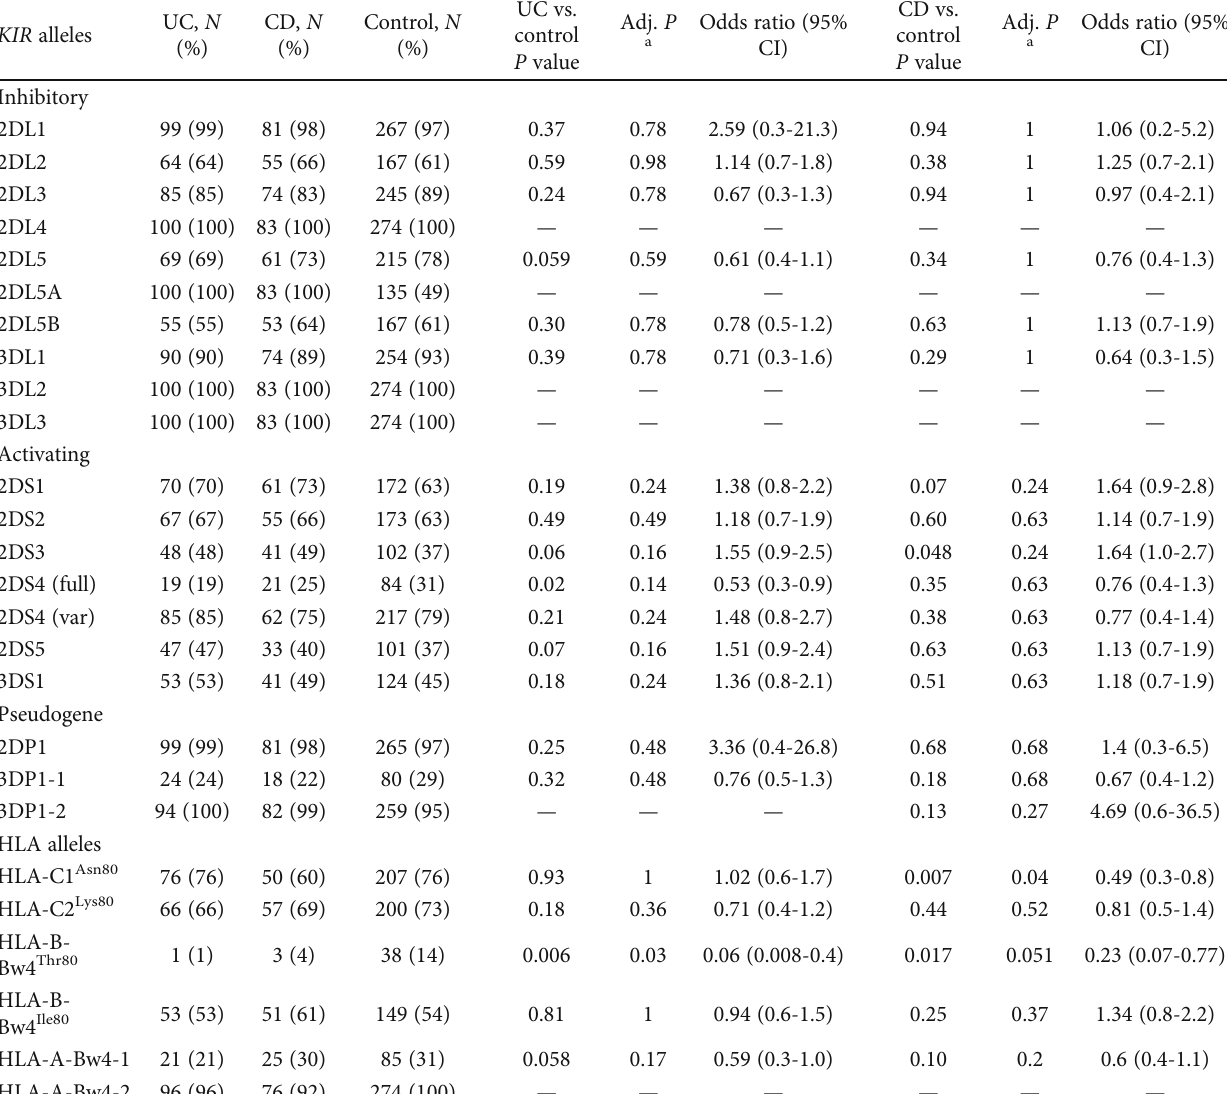
Table 1: Comparison between KIR and HLA gene frequencies in the IBD and control groups. KIR